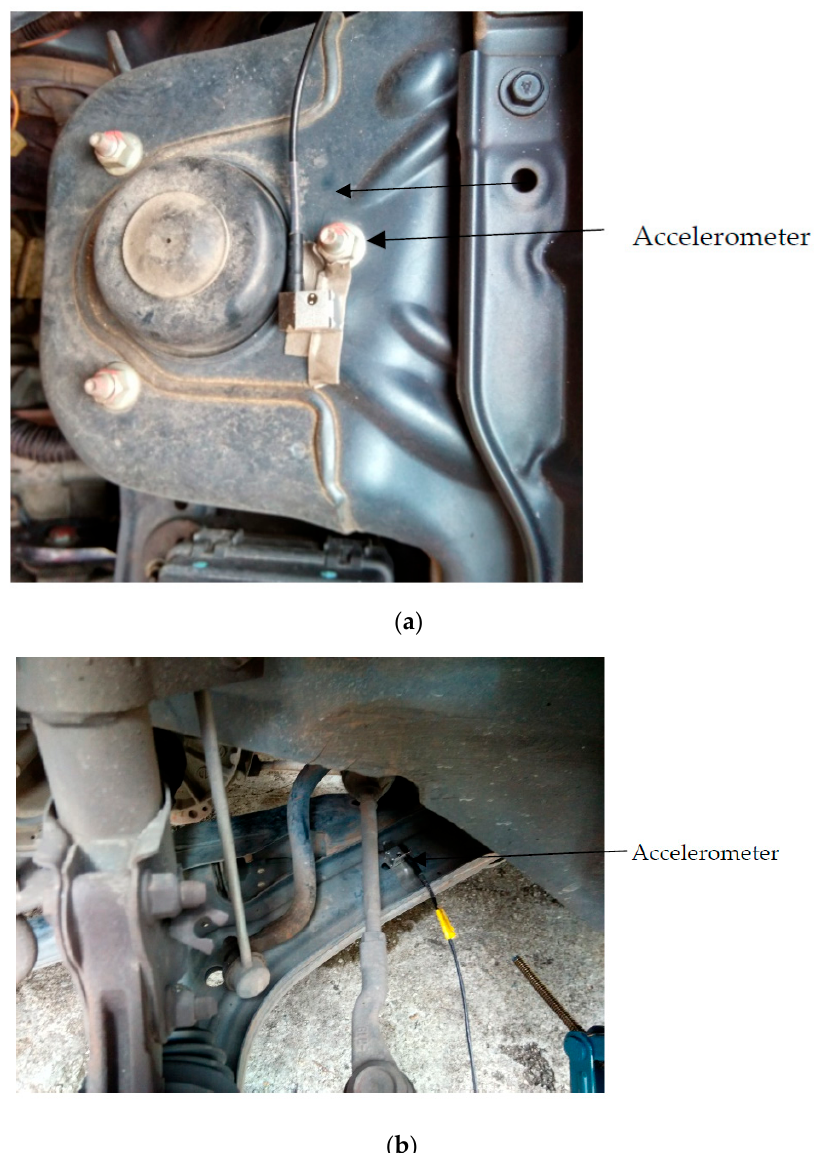
Figure 3. Accelerometer setup: ( a ) Top mount, ( b ) lower arm.